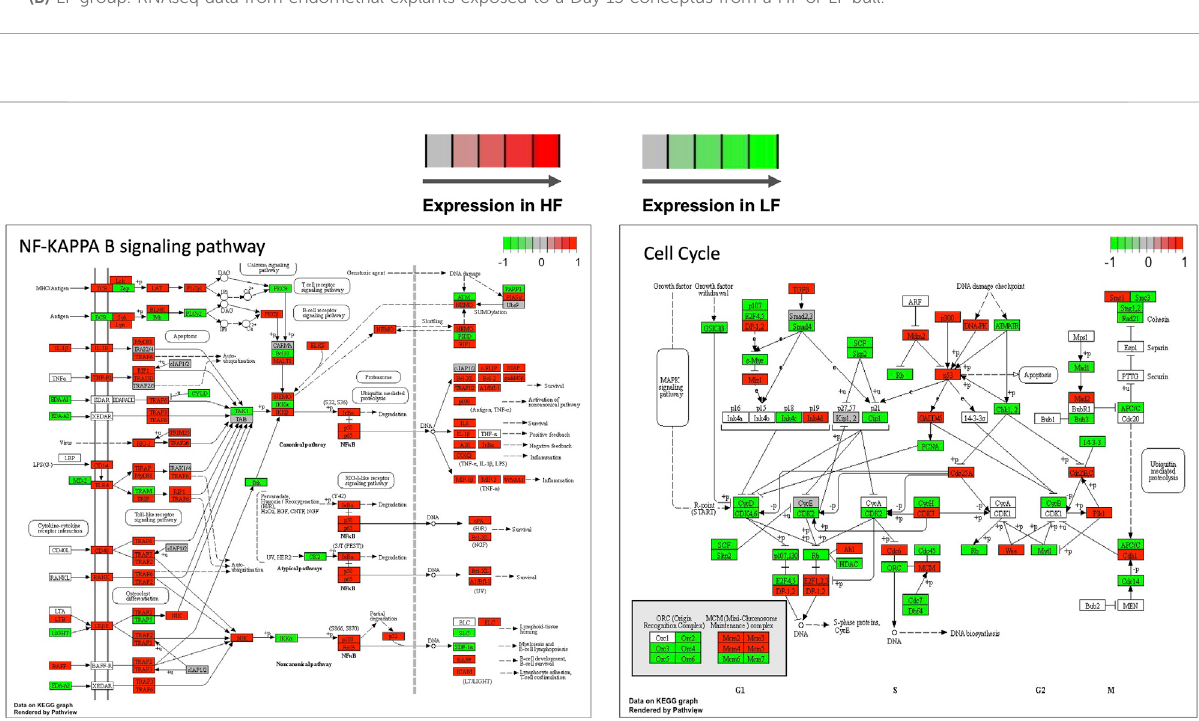
FIGURE 7 SelectedKEGGpathwaysmappedwiththeexpressionofgenesinhighfertility(HF)orlowfertility(LF)groups.Themoreintensetheredorgreen each gene is colored, the more expressed is the gene in the HF or LF groups, respectively. RNAseq data from endometrial explants exposed to a Day 15 conceptus from a HF or LF